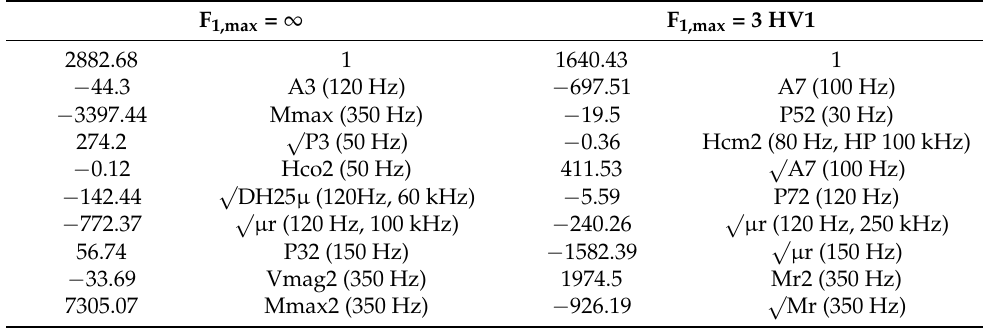
Table 6. Overview of the regression results for hardness (calibration data set).